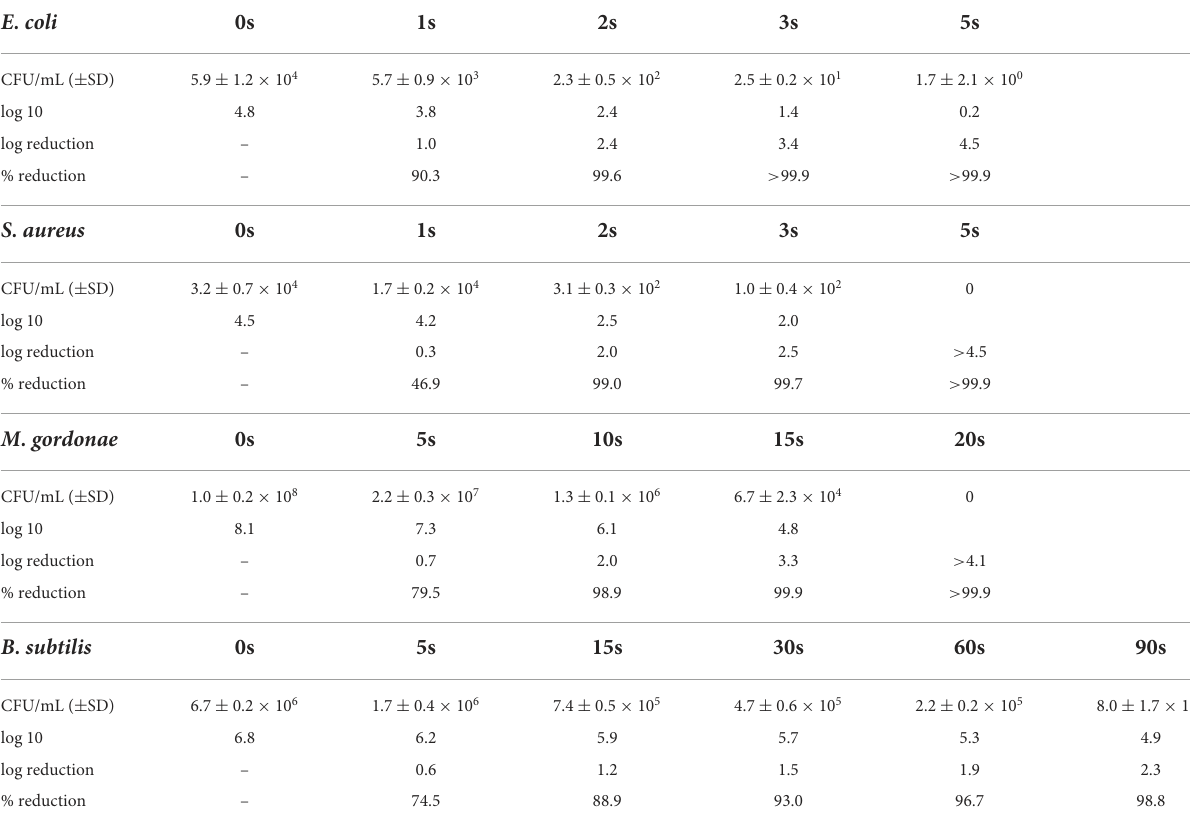
TABLE 1 Differences in the infectious titer after DUV-LED irradiation against the plates coated by each bacterial solution. E.